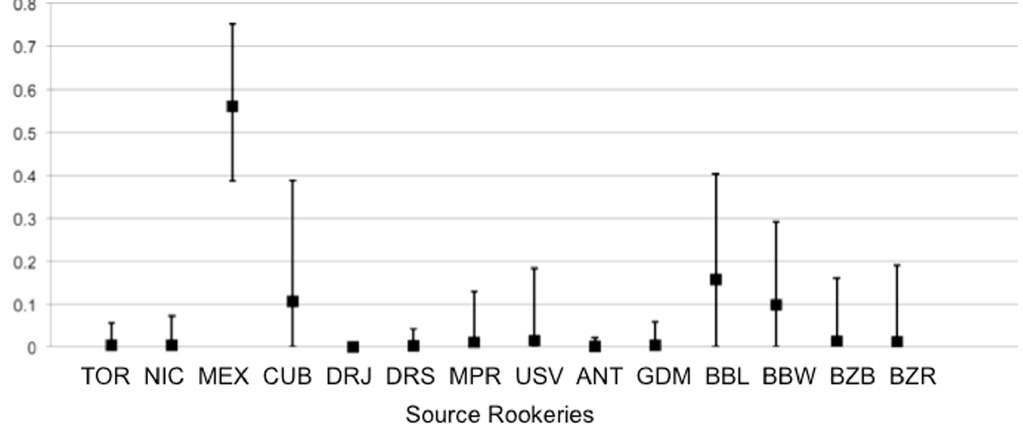
Fig. 4. Rookery contribution estimates for juvenile hawksbill turtles foraging in the KWNWR based on mixed stock analysis weighted by rookery size. Rookery source codes are explained in S1